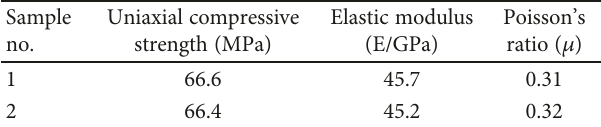
Table 10: Erosion depth of the di ff erent